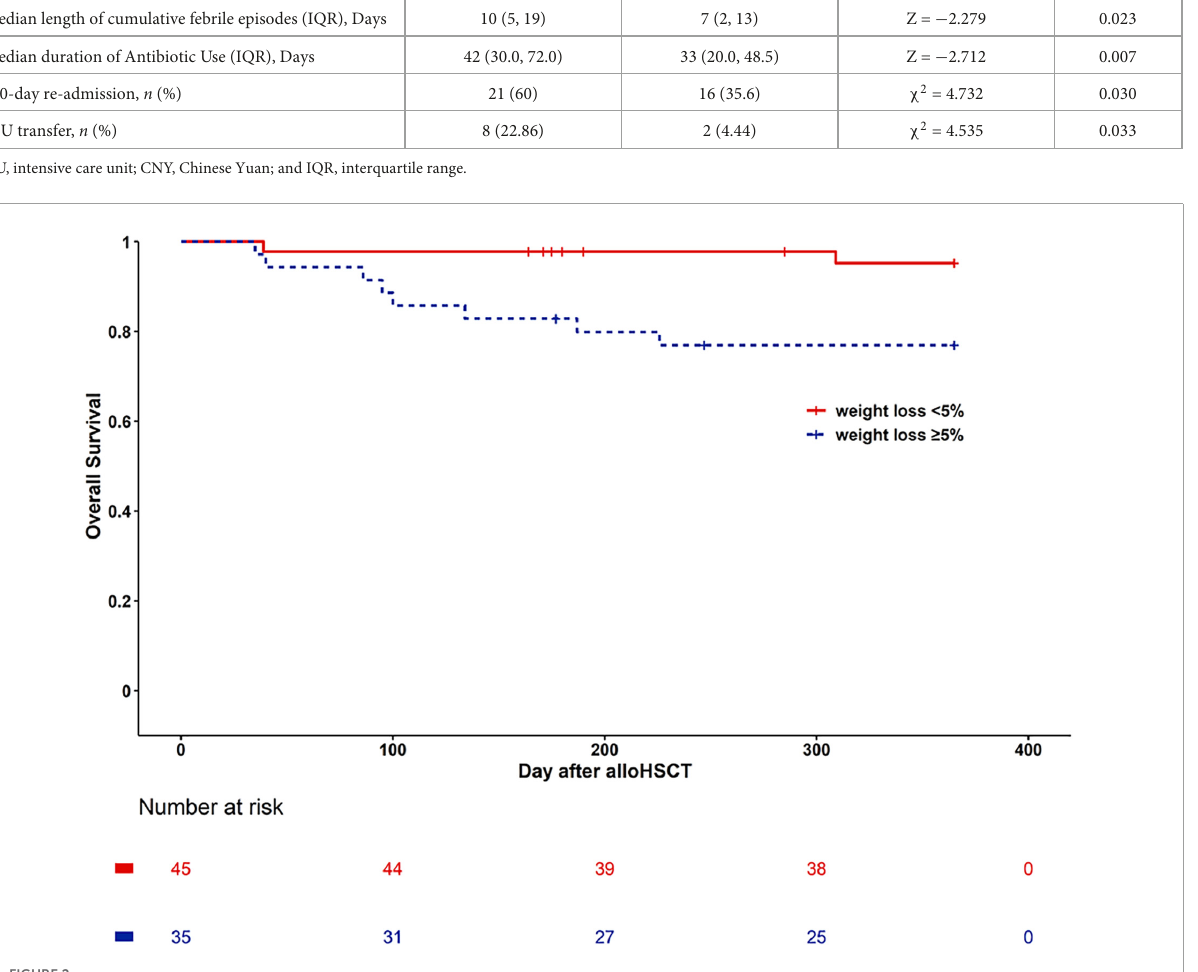
FIGURE2 Kaplan Meier curves of survival for weight loss < 5% group (continuous line) and weight loss ≥ 5% (dashed